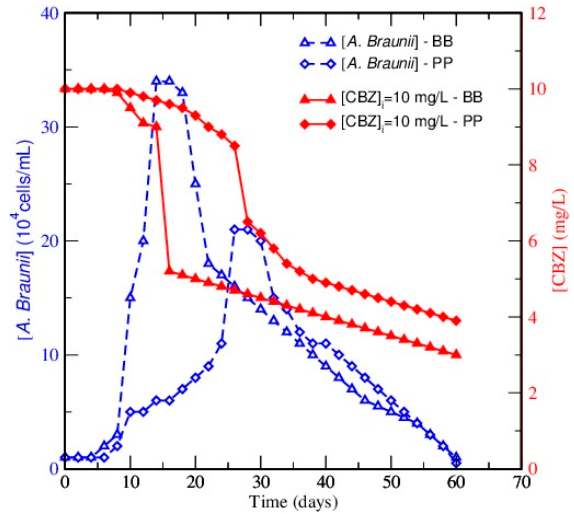
Figure 2. Effect of the culture media on CBZ removal for an initial pollutant concentration of 10 mg/L and an initial inoculum concentration of 10 4 cells/mL.